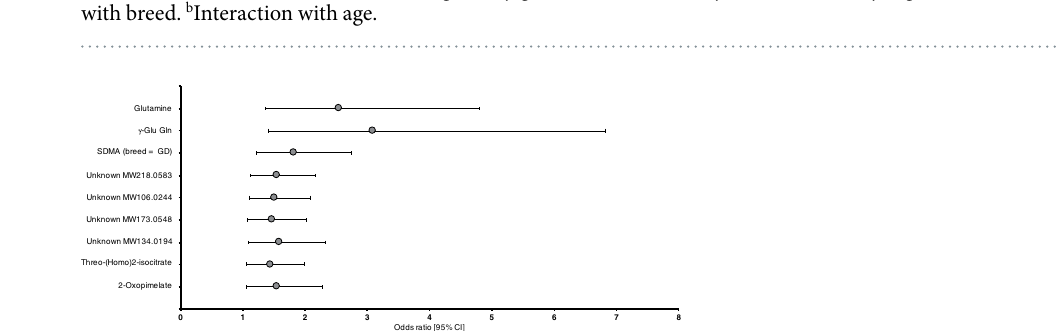
Table 3. Receiver operator characteristic (ROC) curve analysis of the metabolites. AUC = area under the curve, CI = confidence interval, γ -Glu Gln = γ -glutamylglutamine, SDMA = symmetric dimethylarginine. a Interaction with breed. b Interaction with age.